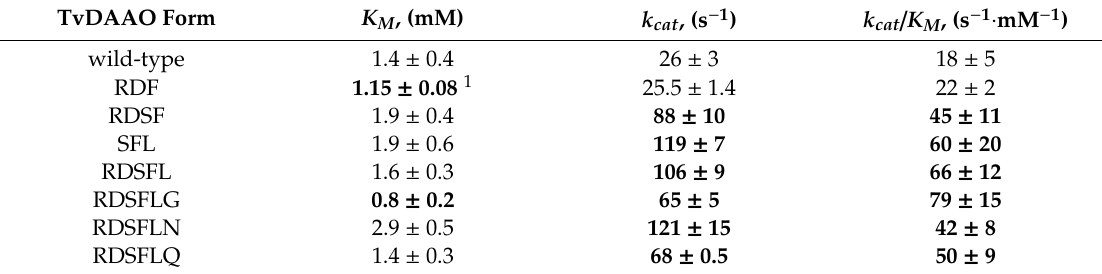
Table 4. Catalytic parameters of mutant TvDAAOs with cephalosporin C (0.1 M potassium phosphate bu ff er pH 8.0, 30 ◦ C, air saturated).